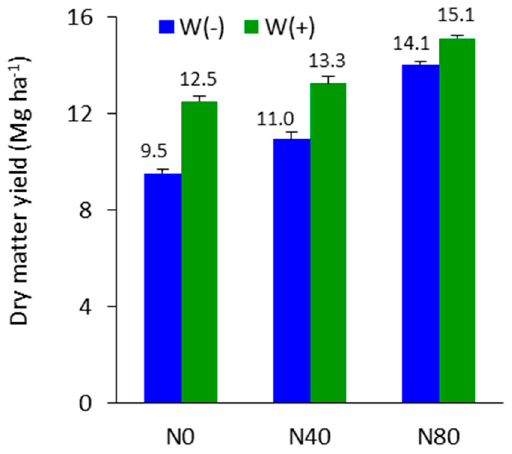
Figure 2. Cup plant dry weight yield.